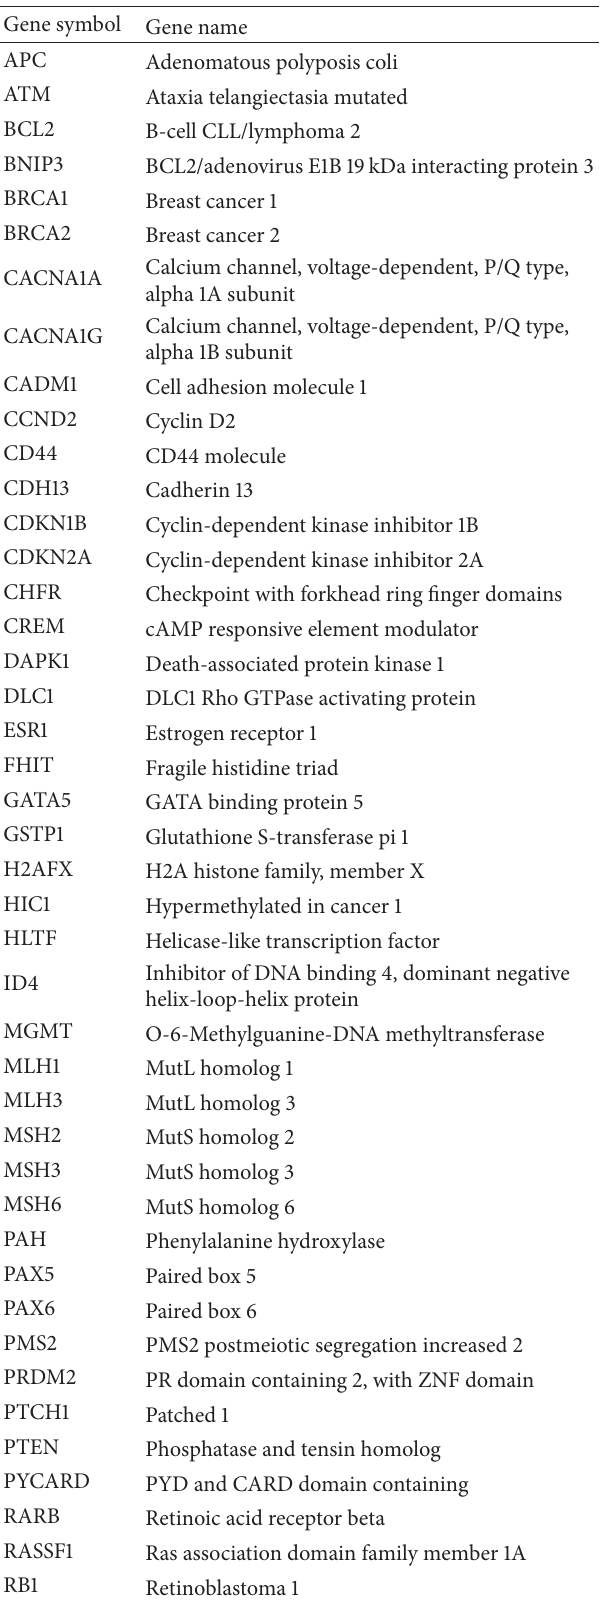
Table 1: List of genes analyzed in the gastric leiomyoma. Gene names and gene symbols are according to the HGNC database.